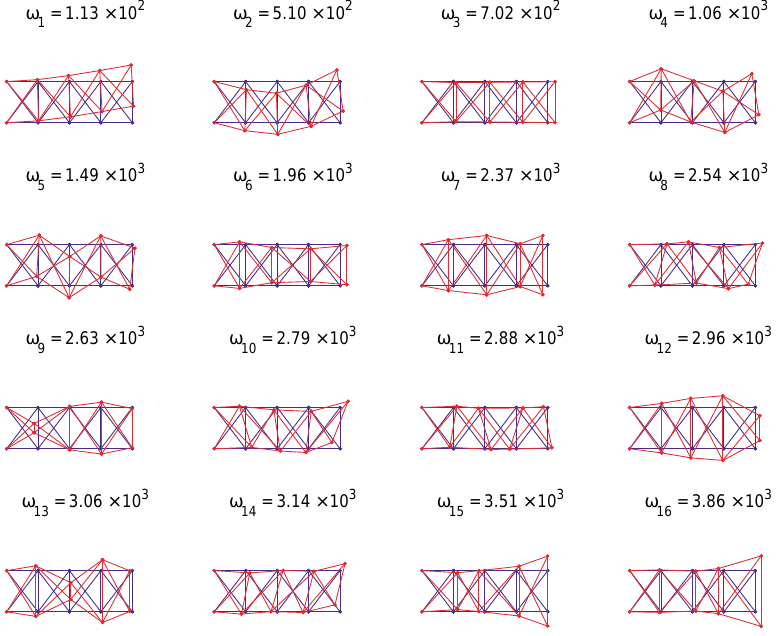
Fig. 2. Analytical mode shapes for the 2D truss with respective frequencies in